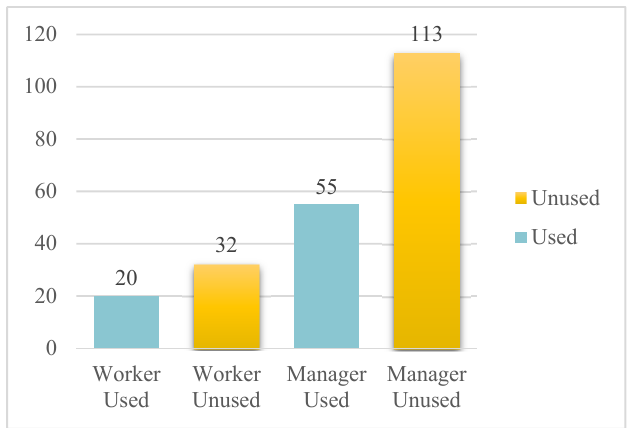
Figure 4. Statistics on the actual use of the intelligent surveillance system.